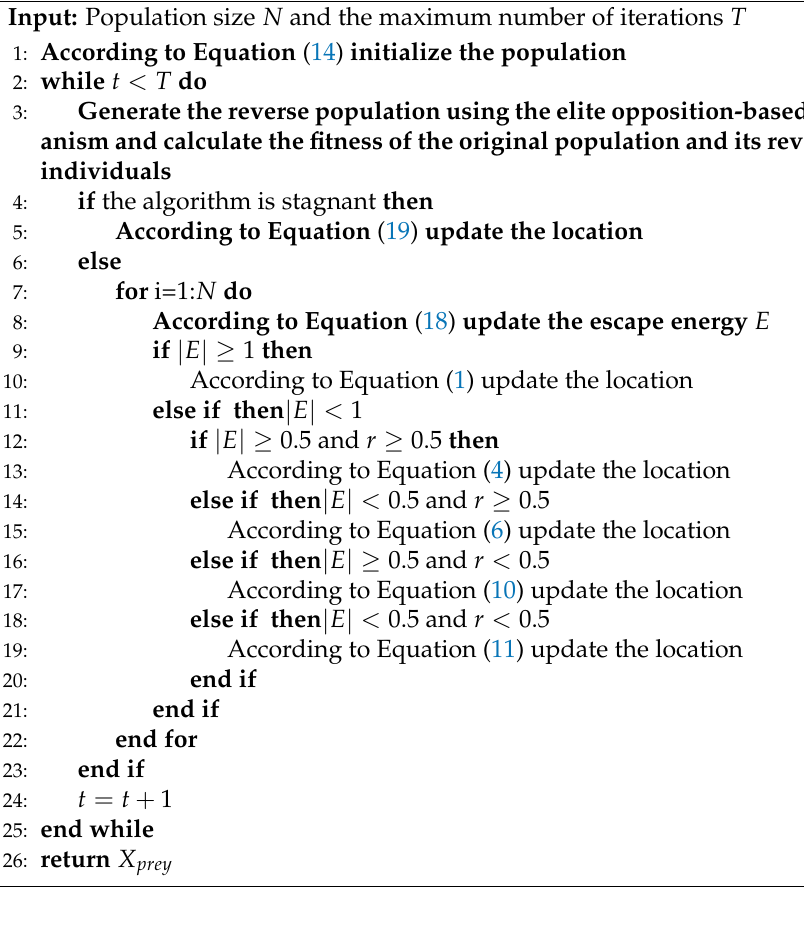
Algorithm 2 Main steps of MSHHO